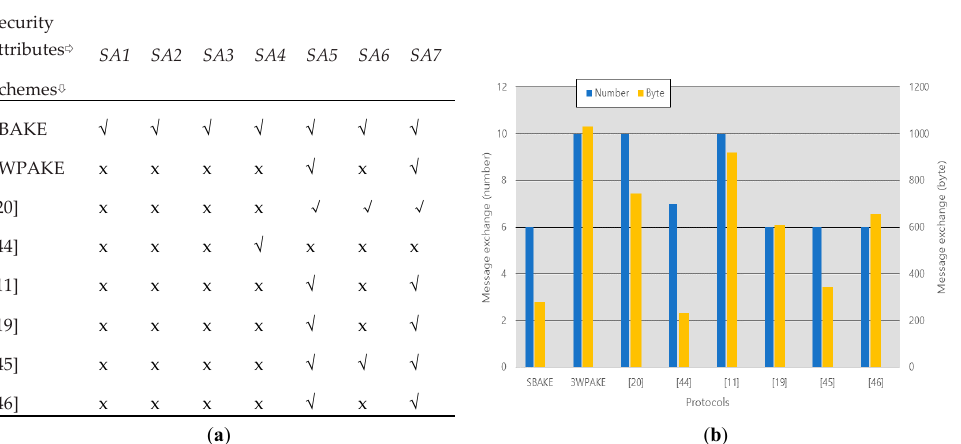
Figure 3. ( a ) SA1: provide anonymity, SA2: provide untraceability, SA3: provide mutual authentication, SA4: resist privileged insider attack, SA5: provide session key secrecy, SA6: resist offline password guessing attack, SA7: provide perfect forward secrecy, √ : yes, x: no; ( b ) performance comparison between SBAKE and existing other protocols.